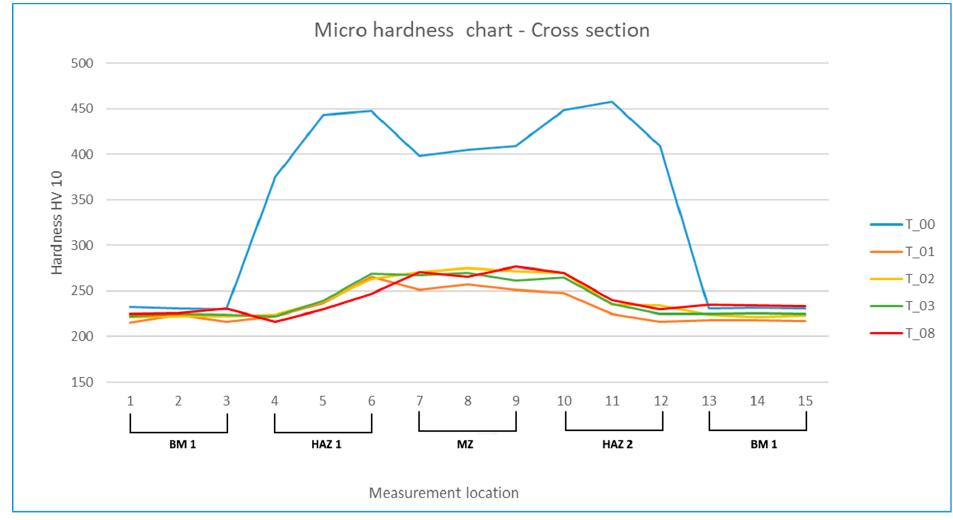
Figure 6. Microhardness profile of the different samples across the welded and neighboring areas.